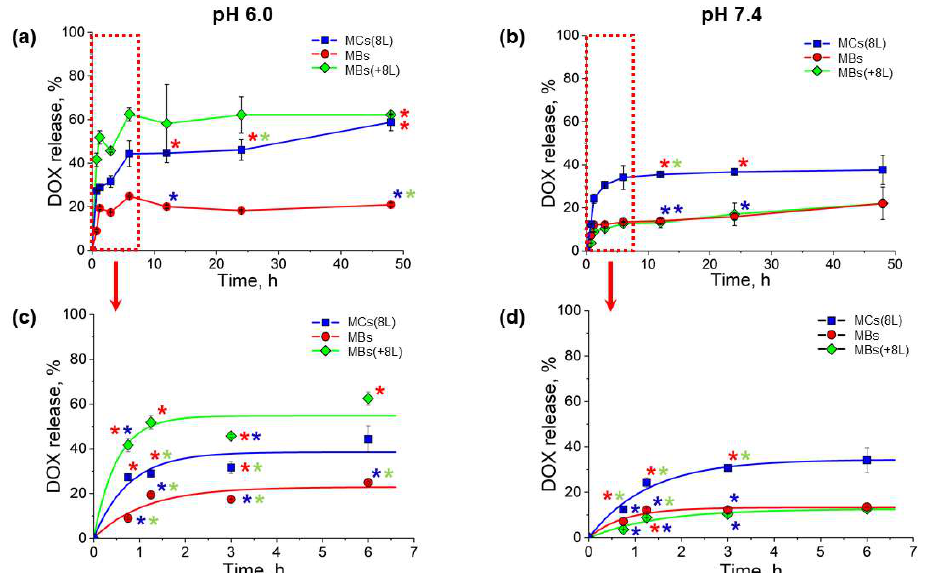
Figure 6. Profiles of doxorubicin release from microcapsules at ( a ) pH 6.0 and ( b ) pH 7.4 during 48 h and profiles of the initial drug release during the first 6 h of incubation at ( c ) pH 6.0 and ( d ) pH 7.4. Asterisks mark the data that significantly differ from one another ( p < 0.05, Student’s t -test).